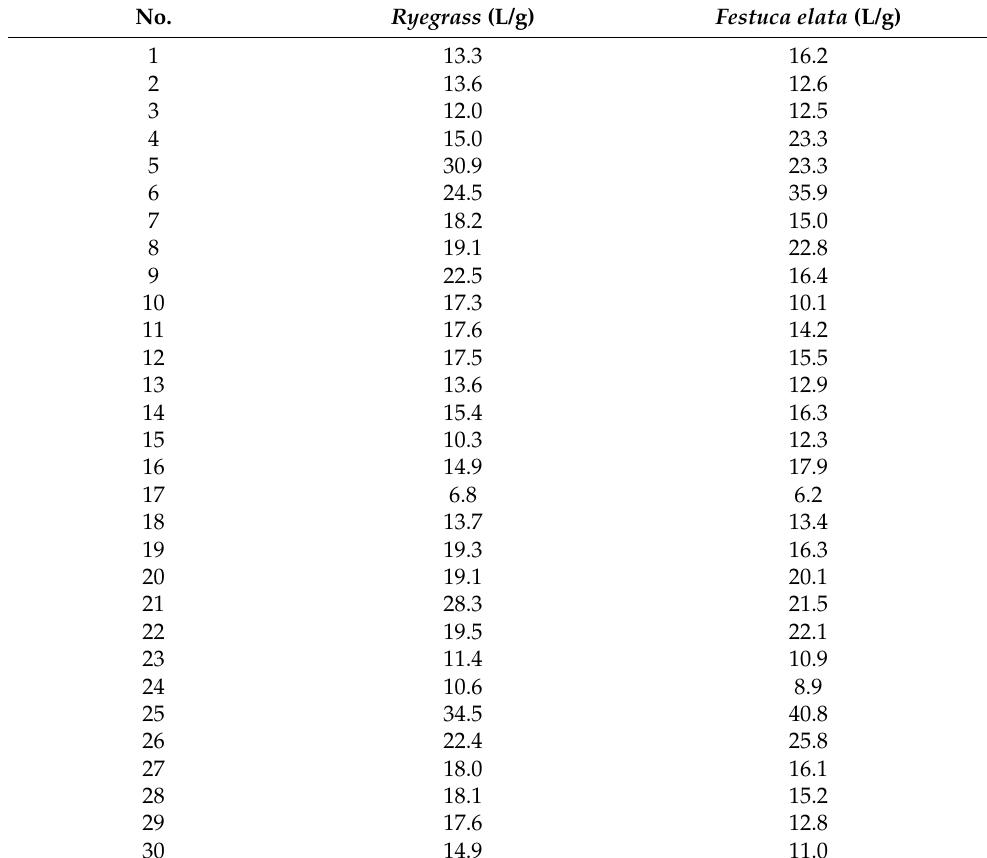
Table 6. SRS results after 60